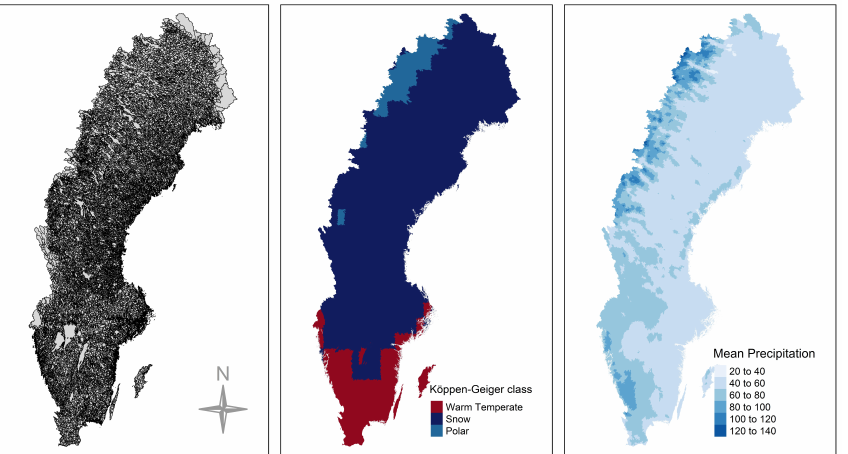
Figure 4. ( left ) Locations of precipitation stations used over Sweden. ( center ) Spatial distribution of the Köppen-Geiger climate classification system. ( right ) Mean monthly precipitation (mm) during the period